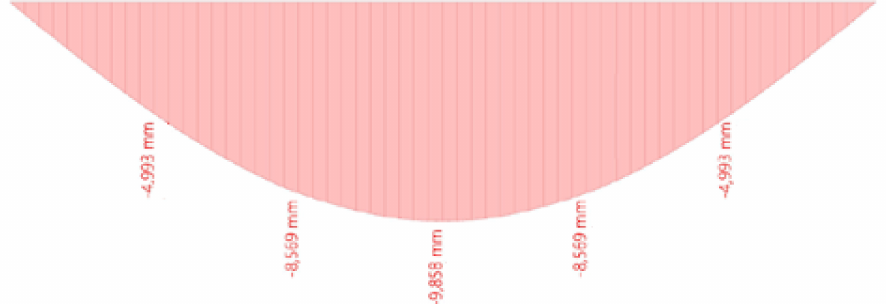
Figure 12. Results of the static analysis of vertical displacements of the beam